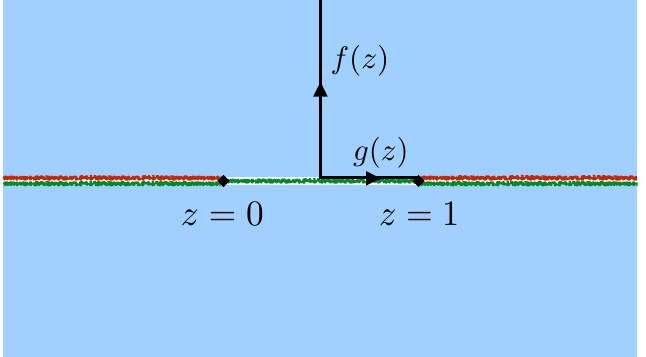
Figure 2 . The representation of a general functional in terms of a pair of weight functions f ( z ) and g ( z ). The branch cuts of f ( z ) are shown in green. The branch cuts of g ( z ) coincide with those of the bootstrap vectors F (cid:1) (cid:30) ( z ) and are shown in red. The integration contours approach (cid:1) the boundary of R at z = 1 and z = 1, and consequently f ( z ) and g ( z ) respectively must have appropriate fall-o(cid:11)